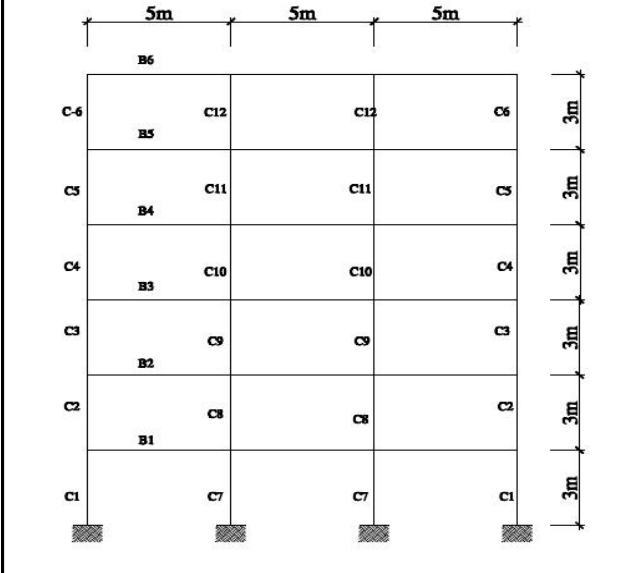
FIG. 1. STRUCTURE